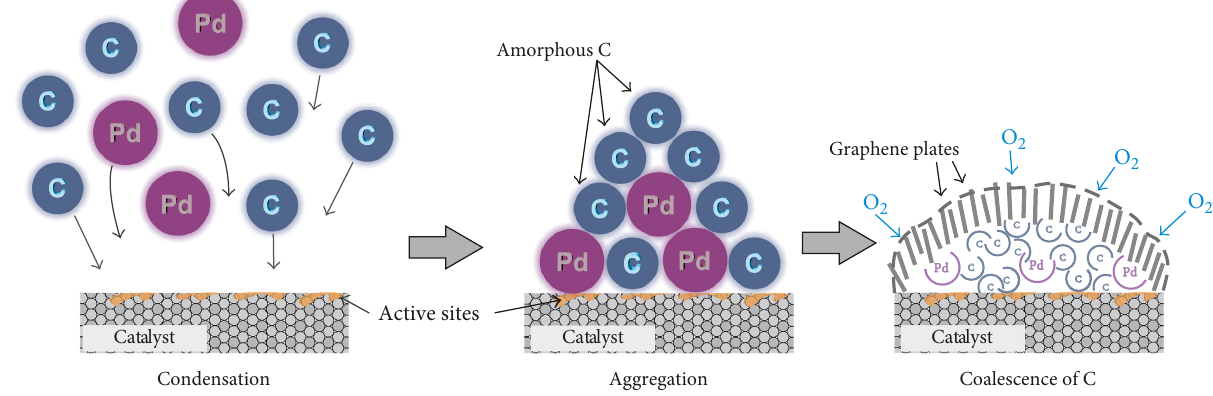
Figure 6: Principle mechanism of Pd/NPs formation.